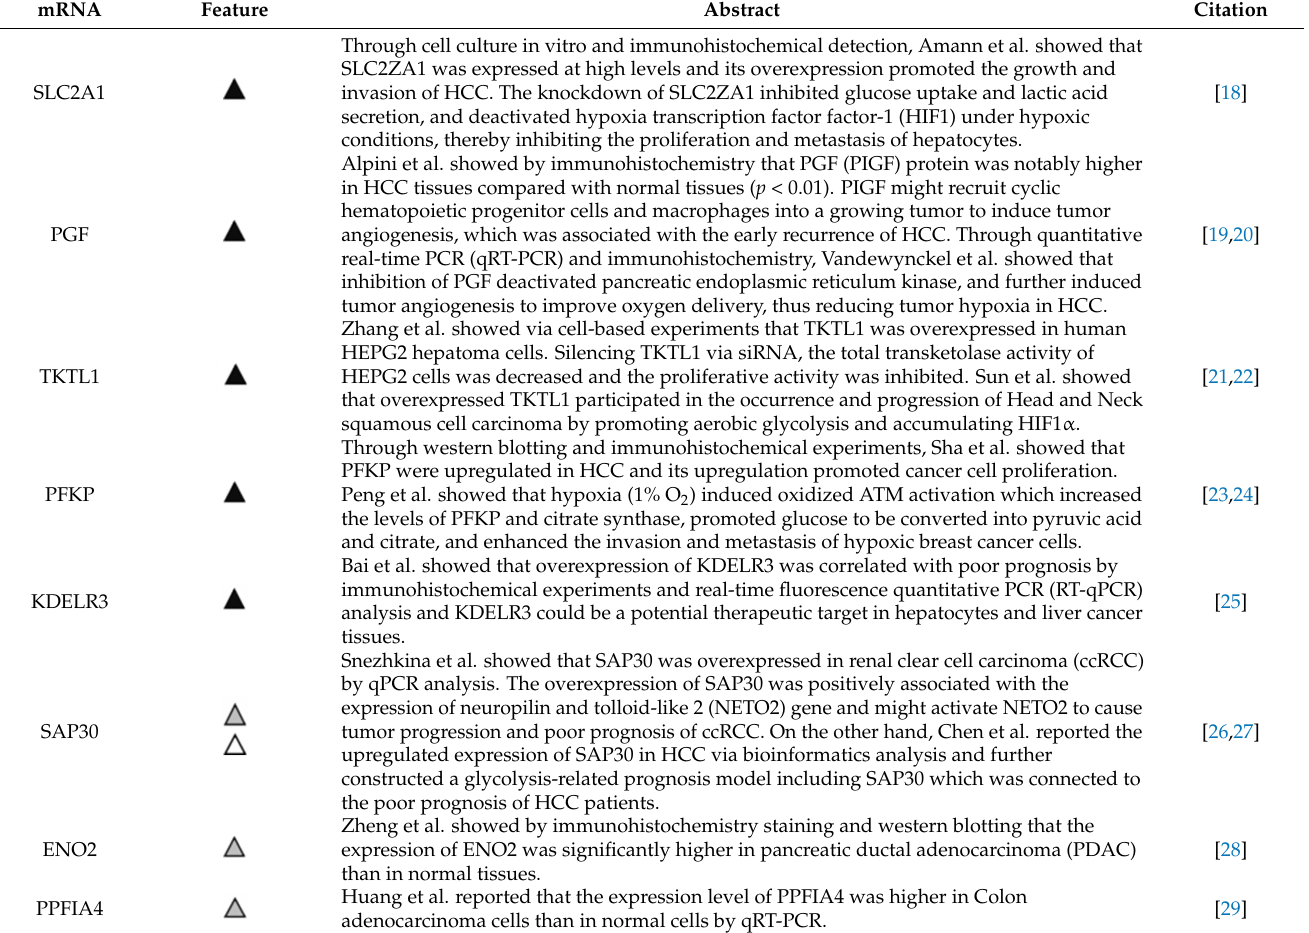
Table 2. A comparison between the abnormal expressions of eight prognostic model-related hypoxia mRNAs reported in this study and previous